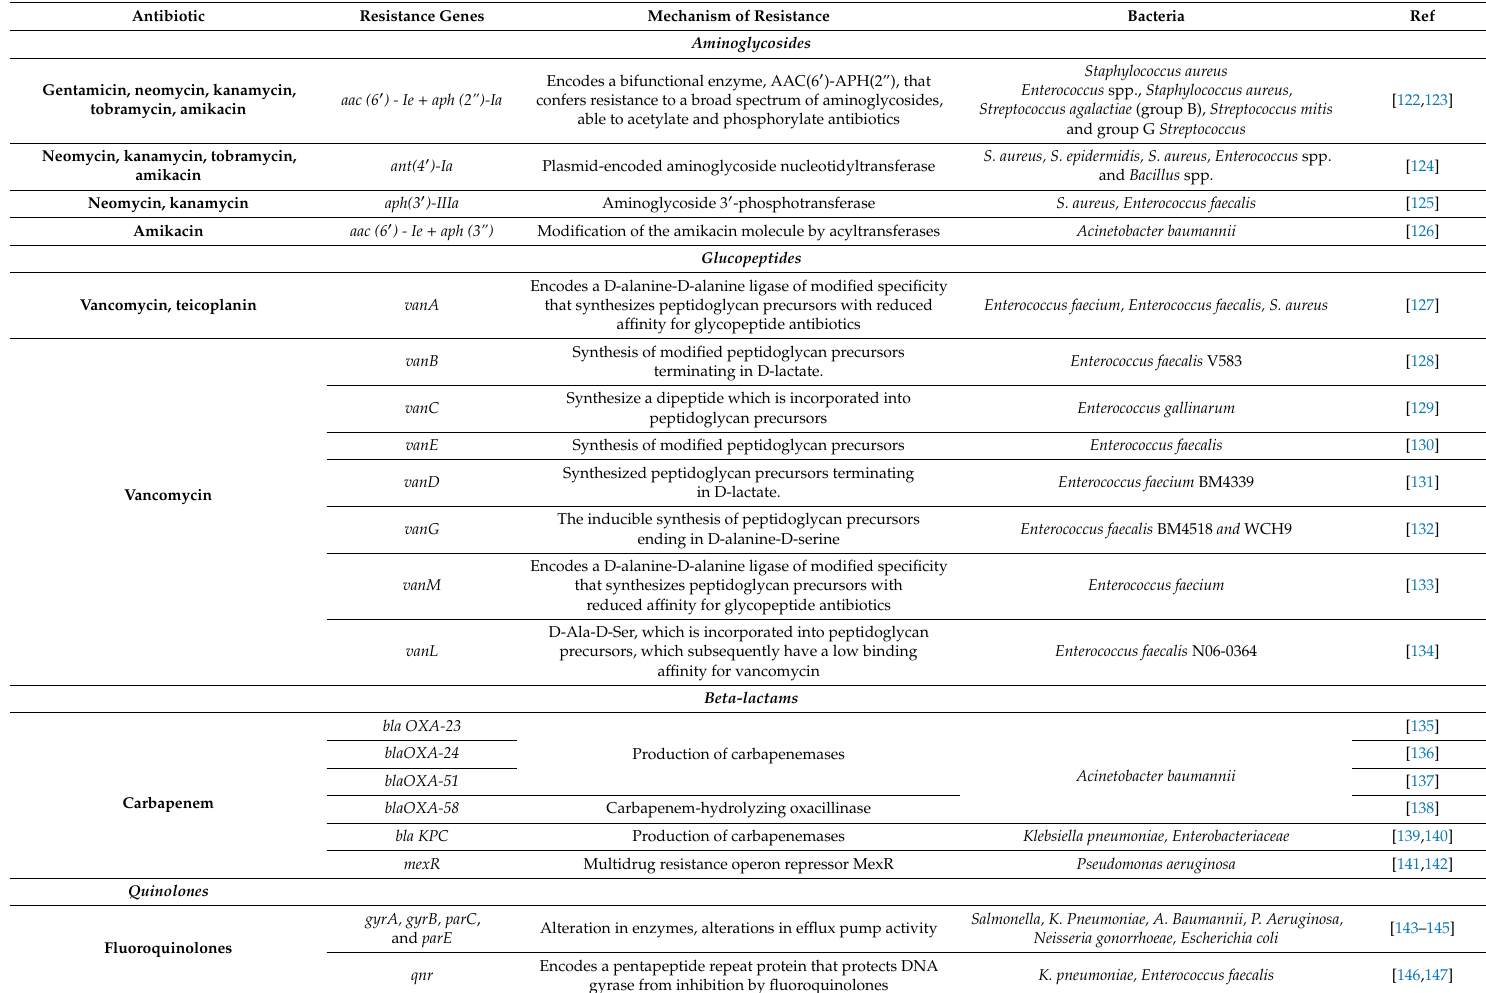
Table 1. Involved genes in bacterial